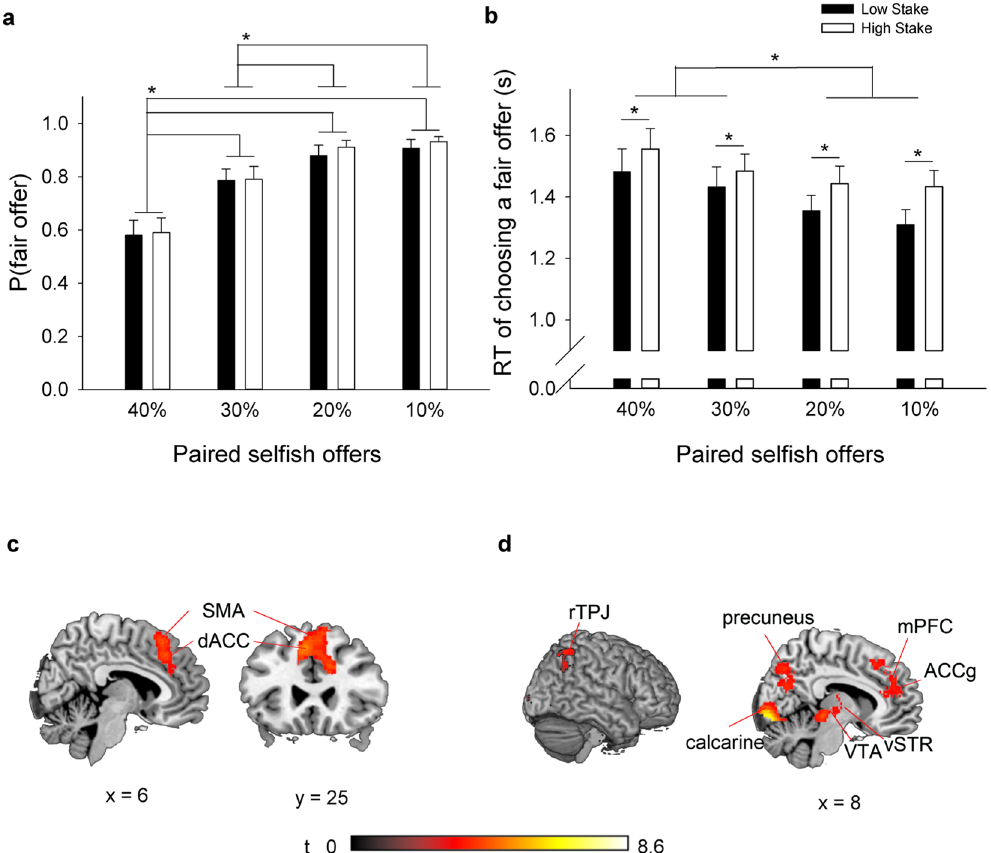
Figure 1. Effect of share size and stake size when choosing a fair offer. ( a ) Estimated proportion of fair offers; ( b ) average reaction times when proposers chose a fair offer over a selfish offer with different share sizes (i.e., offering 40%, 30%, 20%, and 10% of the stake) in different stakes. Error bars indicate standard errors. * p < 0.05; ( c ) significantly greater activation of a fair offer paired with a slightly selfish offer (i.e., offering 40% or 30%) than a very selfish offer (i.e., offering 20% or 10%), and ( d ) in high stakes than in low